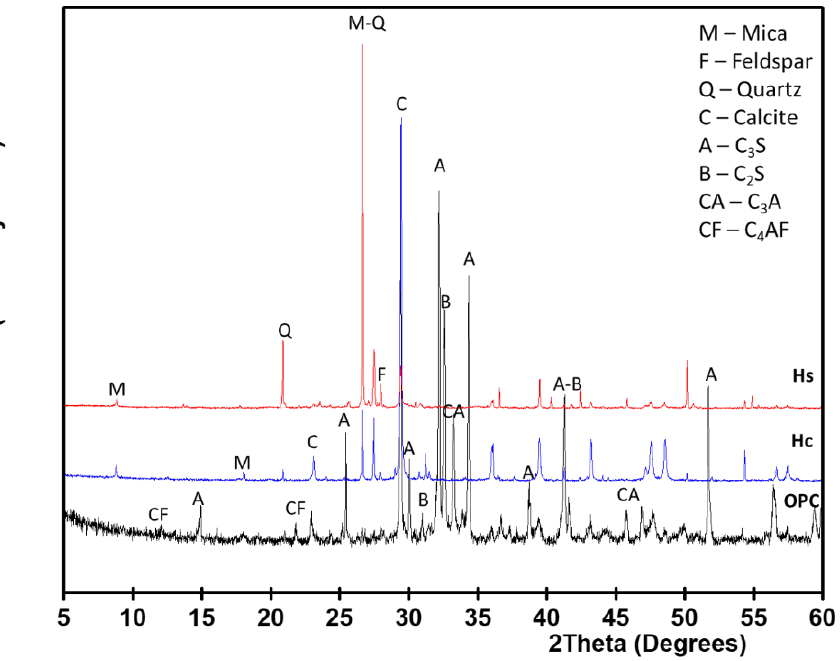
Figure 1. XRD patterns of the materials analyzed. Table 1. Mineralogical composition of the materials quantified by the Rietveld method.